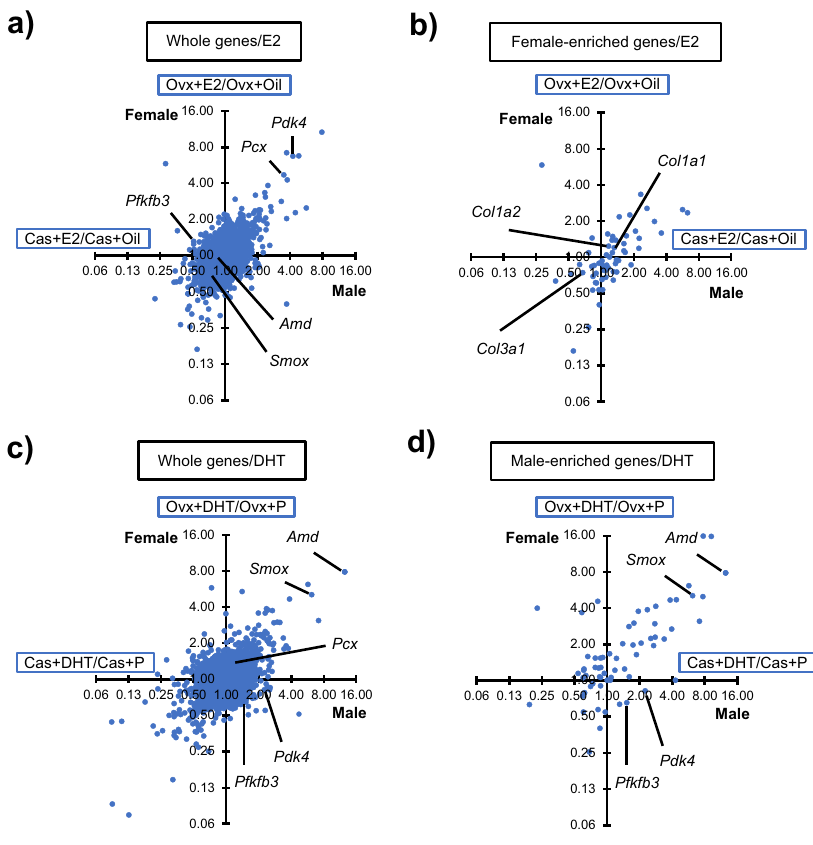
Fig. 3 Identi fi cation of genes whose expression is potentially affected by sex steroids. a , b Induction ratios by E2 treatment, speci fi cally Cas + E2/Cas + O (horizontal axis) for males and Ovx + E2/Ovx + O (vertical axis) for females, were calculated and plotted for all expressed genes ( a ) and for the female- enriched genes ( b ). c , d Induction ratios by DHT treatment, speci fi cally Cas + DHT/Cas + P for males (horizontal axis) and Ovx + DHT/Ovx + P for females (vertical axis), were plotted for all expressed genes ( c ) and for the male-enriched genes ( d ). The scales are logarithmic. The locations of Pdk4 , Pfkfb3 , Pcx , Amd , Smox , Col1a1 , Col1a2 , and Col3a1 , are